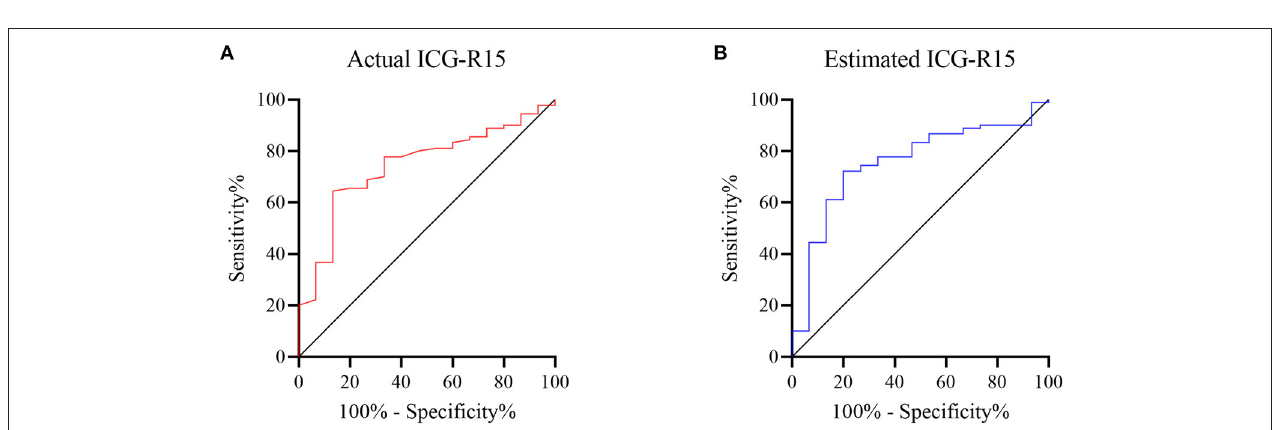
FIGURE 2 | Scatter plots show actual vs. estimated ICG-R15 in the test cohort with great agreement. Three machine learning models [random forest regression (RFR), extreme gradient boosting regression (XGBR), and artificial neural network (ANN)] were developed and Pearson correlation coefficient ( R ) was adopted to assess the correlation between actual and estimated ICG-R15 in the test cohort. (A) RFR, R = 0.89; (B) XGBR, R = 0.90; (C) ANN, R = 0.85. ICG-R15, indocyanine green retention rate at 15min; RFR, random forest regression model; XGBR, extreme gradient boosting regression model; ANN, artificial neural network model.